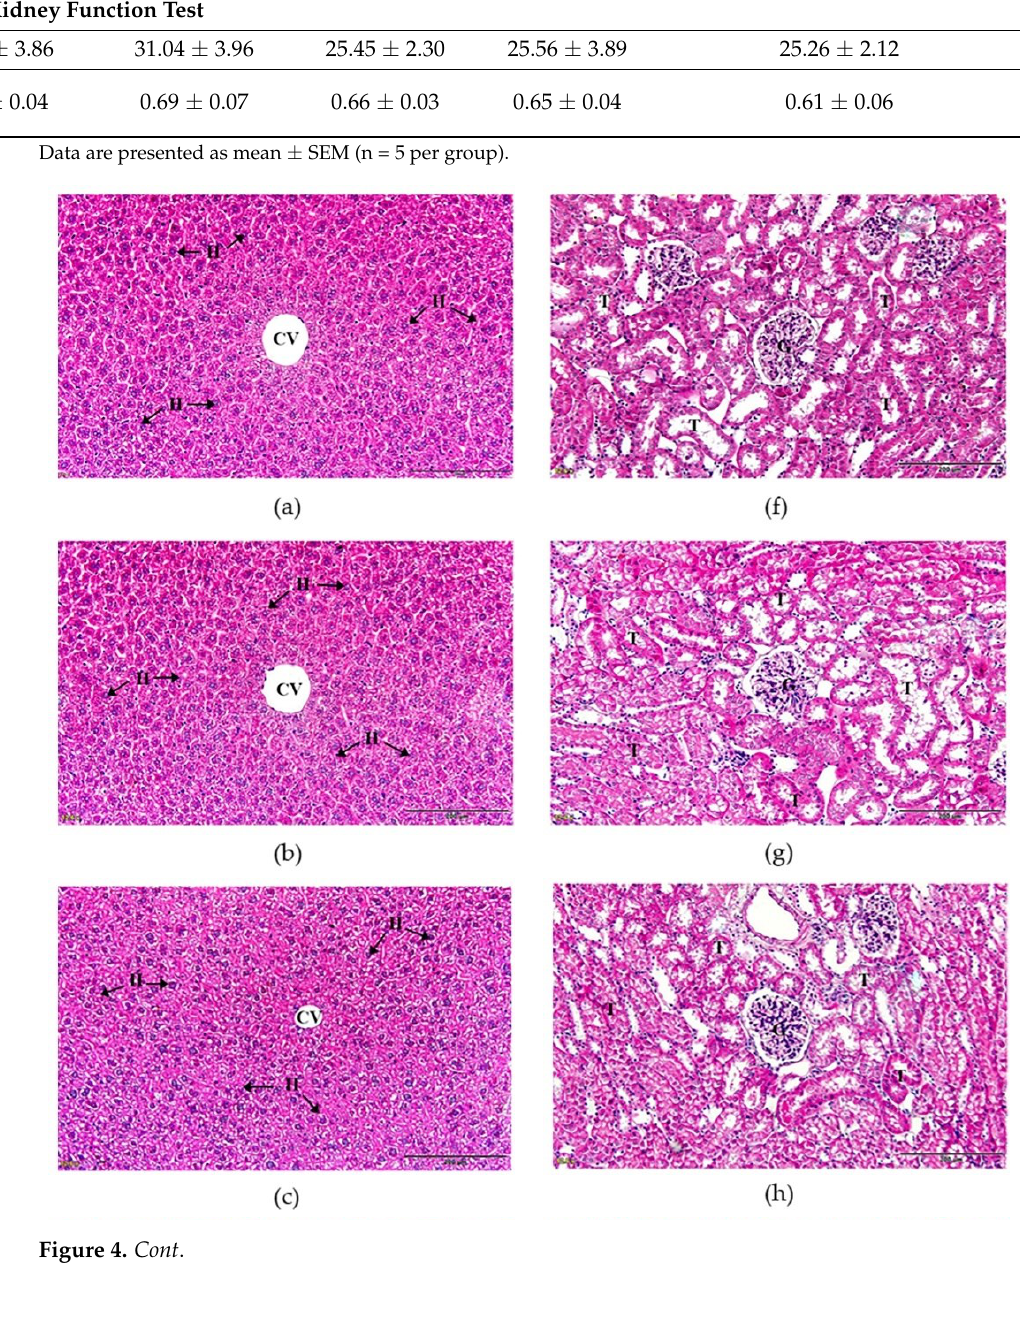
Figure 4. Histopathological examination of liver and kidney tissues from ICR mice that adminis- trated with ethanolic extract from M. fragrans , A. lancea , and Prabchompoothaweep remedy in acute